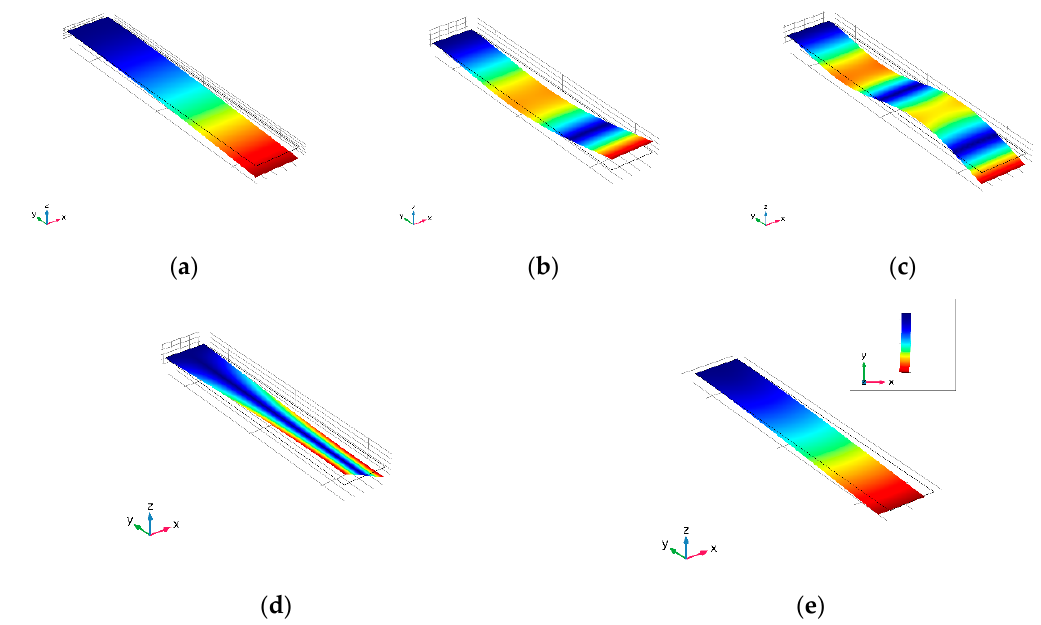
Figure 6. 3D Visualization of simulated deflection with the maximum value. ( a ) 3D Visualization of simulated deflection in 1st z -Bending mode; ( b ) 3D Visualization of simulated deflection in 2nd z -Bending mode; ( c ) 3D Visualization of simulated deflection in 3rd z -Bending mode; ( d ) 3D Visualization of simulated deflection in Torsional mode; ( e ) 3D Visualization of simulated deflection in x -Bending mode. Table 3. The actuating and signal read-out methods applicable to different vibration modes of MCL. Resonant